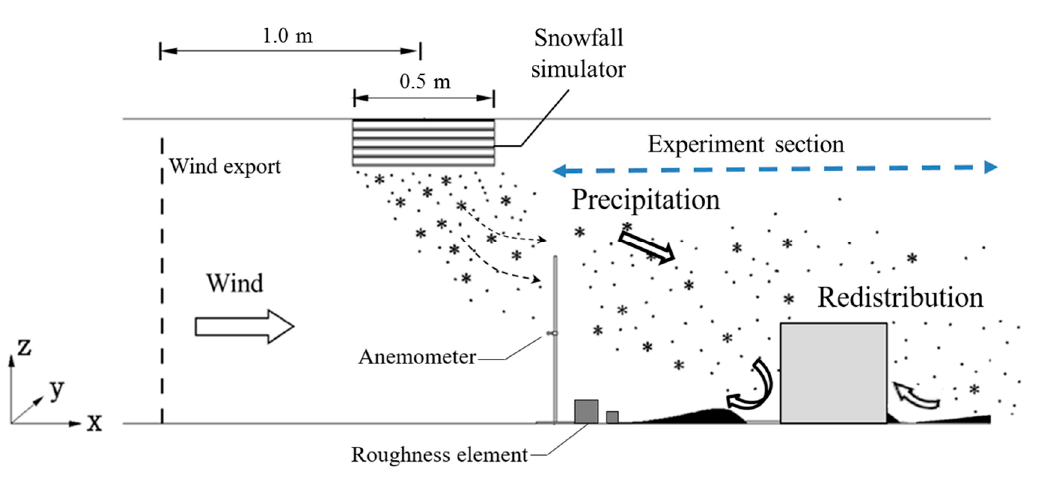
Figure 3. A sketch of the experimental procedure.